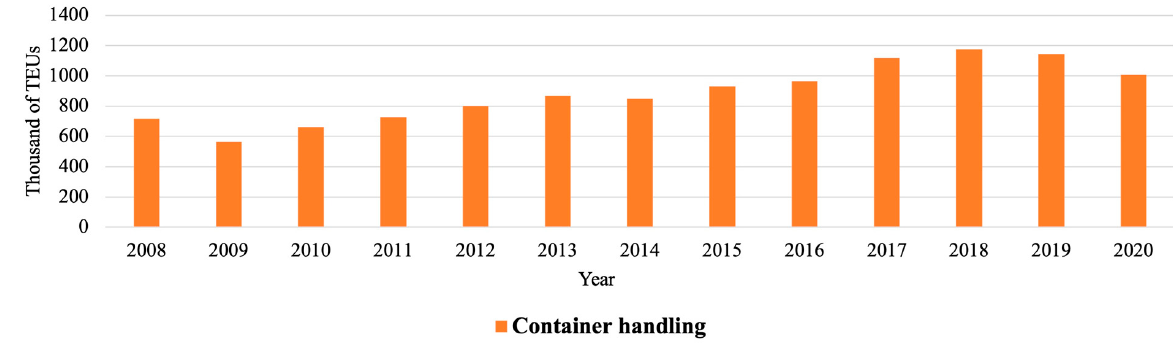
Figure 3. Container handling from 2008 to 2020.